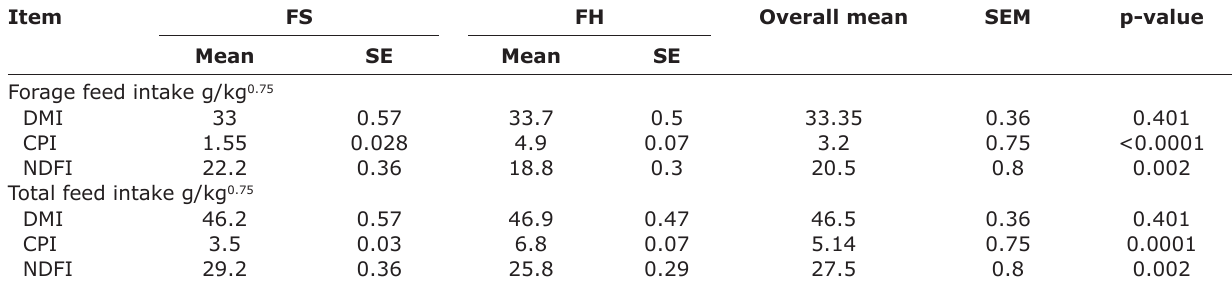
Table-2: Total feed intake and roughage feed intake of camels fed different forage types. Item FS FH Overall mean SEM Mean SE Mean SE Forage feed intake g/kg 0.75 DMI NDFI Total feed intake g/kg 0.75 DMI